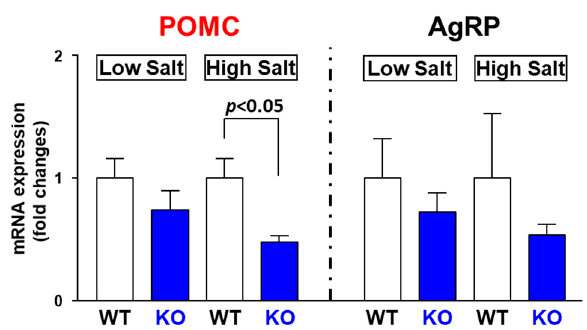
Figure 7. Relative mRNA expression (fold changes) in AgRP and POMC in ARC after 24 h of being fed a high-salt diet. WT mice and Trpv1 KO mice were fed either a low-salt diet (0.3% NaCl) or high-salt diet (8% NaCl) for 24 h. The expression of POMC in ARC was significantly decreased after 24 h of a high-salt diet in Trpv1 KO mice. □ , WT mice; ■ , Trpv1 KO mice. N = 6 for each group. Data are presented as mean ± SEM. WT vs. KO determined by one-way ANOVA followed by the Bonferroni test.